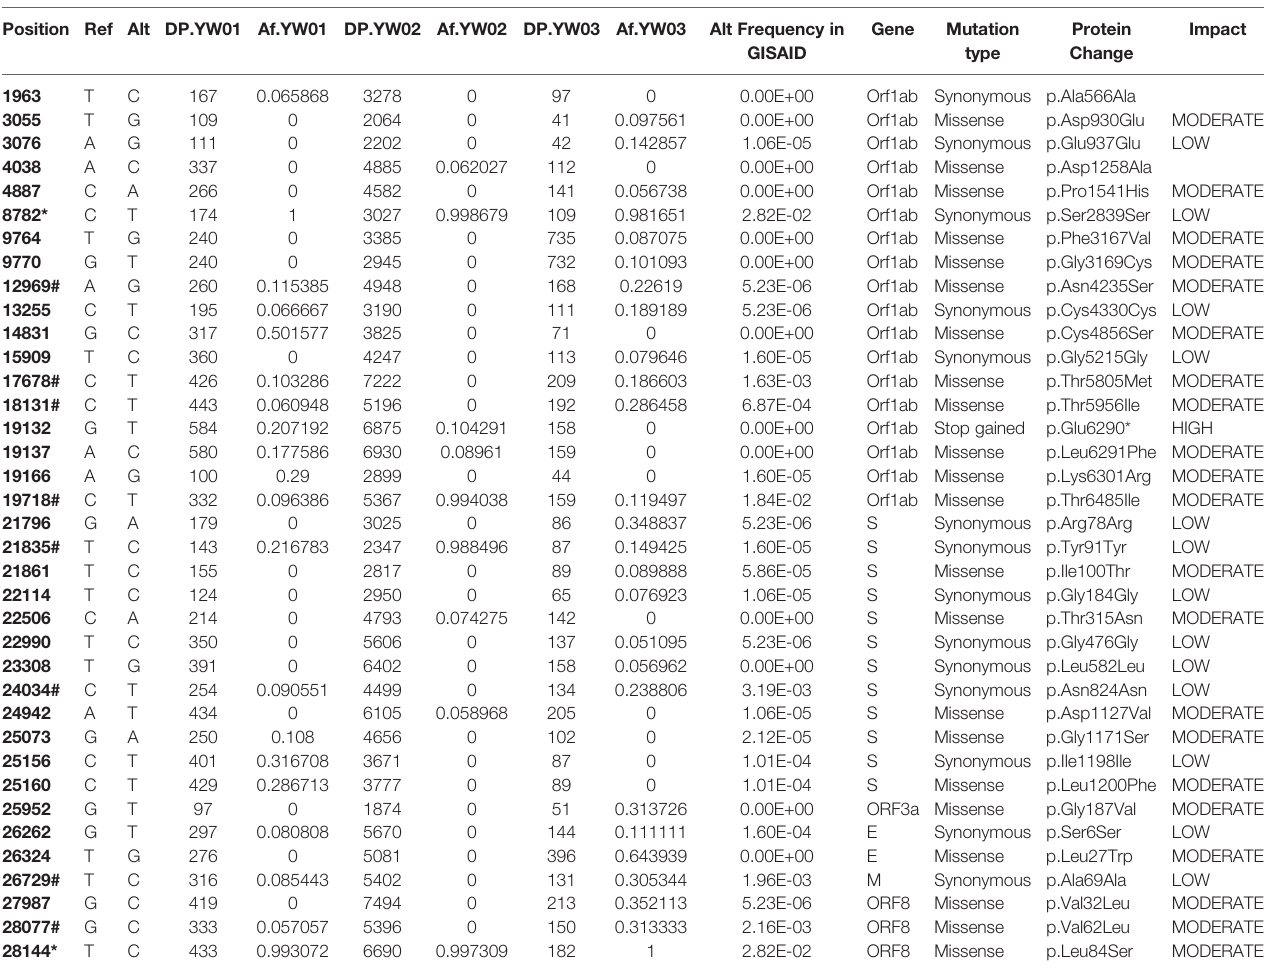
TABLE 1 | Variants in